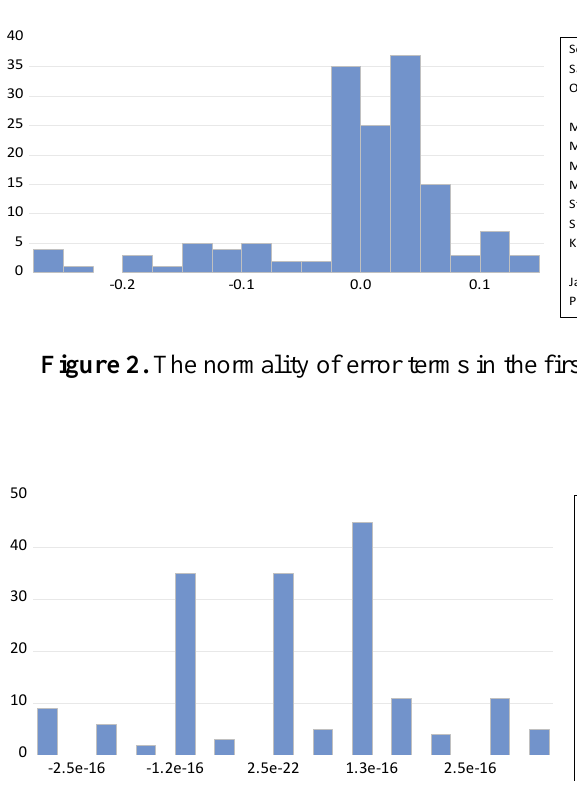
Figure 3. The normality of the error terms in the second hypothesis.